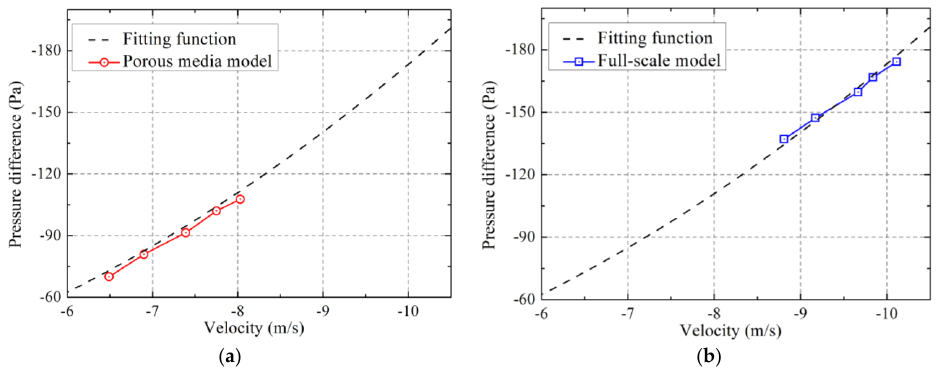
Figure 8. Comparison of the curve-fitted model, full-scale gap model and porous media model: ( a ) comparison of the curve-fitted model (black-dashed line) and porous media model (red-circle line); ( b ) comparison of the curve-fitted model (black-dashed line) and full-scale gap model (blue-rectangle line). The turbulent kinetic energy (TKE) distributions from the porous media model in the frontal and rear PSD areas are shown in Figure 9. The TKE distributions are also similar to each other under the five inflow conditions. The TKE in the rear area varies from about 8.2 m 2 /s 2 to 9.8 m 2 /s 2 , with a trend similar to that of the pressure distribution. Figure 9 also shows that the TKE gradually increases with the inflow velocity.